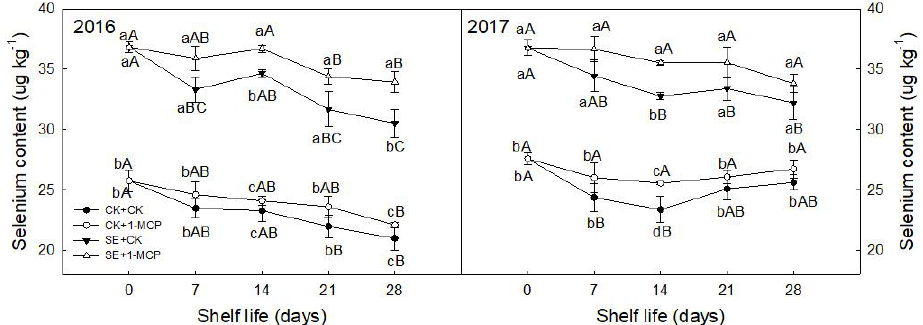
Figure 1. Dynamic changes of Se content in grape berries during shelf life period. Notes: CK—control treatments; SE—Se fertilizer treatments; 1-MCP—1-Methylcyclopropene treatments. Different lower-case letters on the polyline show significant differences ( p < 0.05) between different treatments. Different capital letters on the polyline show significant differences ( p < 0.05) between